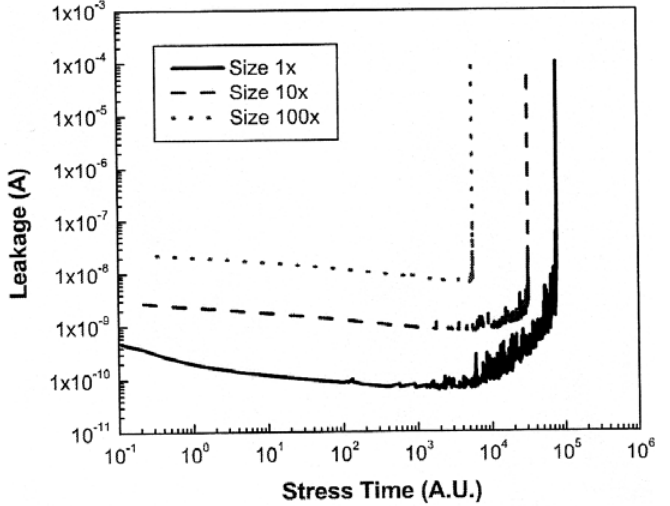
Figure 7. Current voltage characteristics of soft breakdown in Cu ultra low-k test structures with three different test structure sizes (1×, 10×, 100×). Reprinted with permission from Reference [56]. Copyright (2010) by the American Institute of